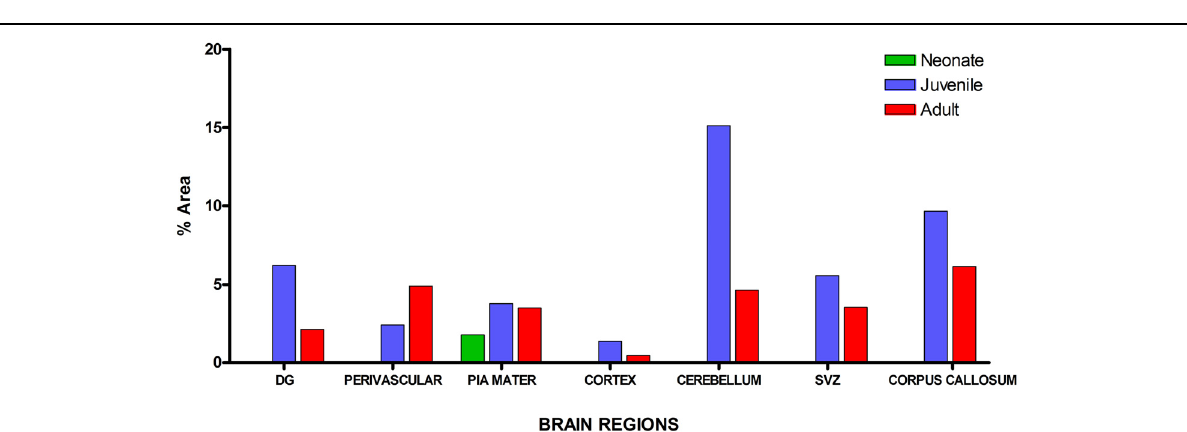
Regional Morphological Heterogeneity in the AGR Brain Astrocyte–Neuron interactions were demonstrated in various brain regions showing terminal neuronal dendritic connections with various astrocytes types. Golgi stain revealed the presence of greater tufts of dendrites in various morphological types of astrocytes than immunohistochemistry. The morphology of astrocytes was also seen to vary throughout the AGR brain using GFAP stain ( Figure 6